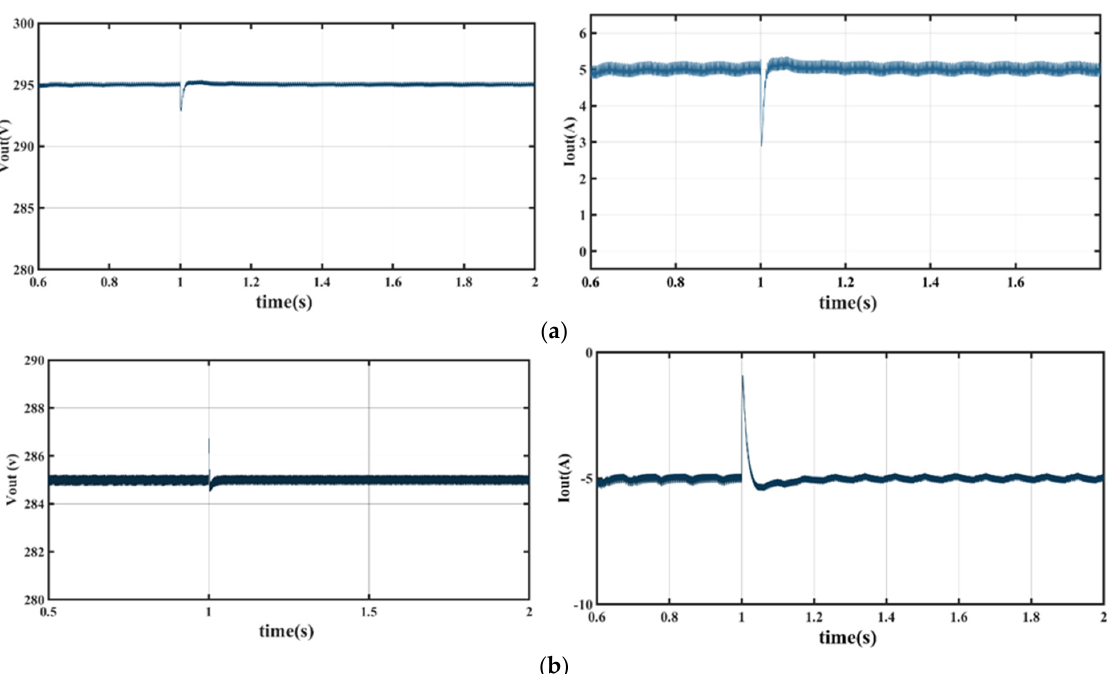
Figure 14. Simulation results for the proposed fault–tolerant topology with the proposed fault di-